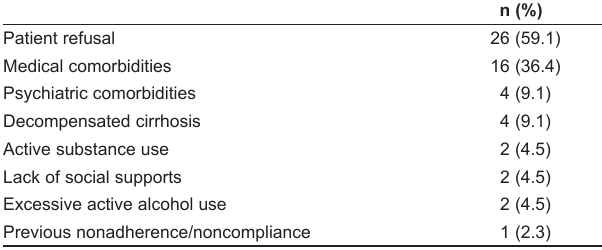
Table 4 Reasons for treatment